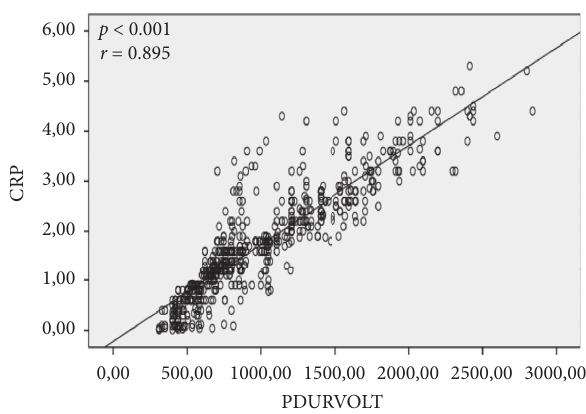
Figure 1: Correlation between P wave duration/P wave voltage and CRP. There is a significant correlation between P wave duration/P wave voltage and CRP ( r � 0.895, p < 0 . 001). CRP: C-reactive protein.